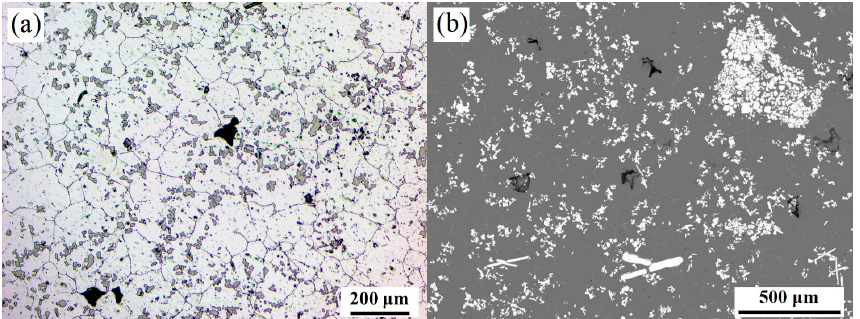
Figure 1. Microstructure of un-remelted Al-5Zr master alloy: ( a ) OM and ( b ) SEM images.